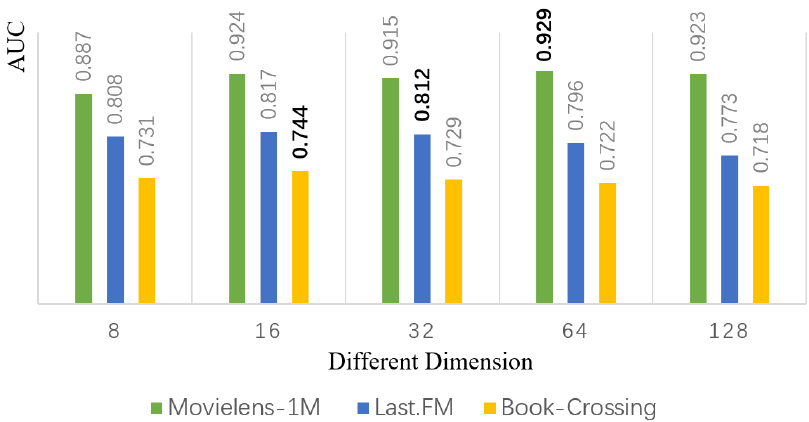
Figure 6. Performance in Different Dimensions.